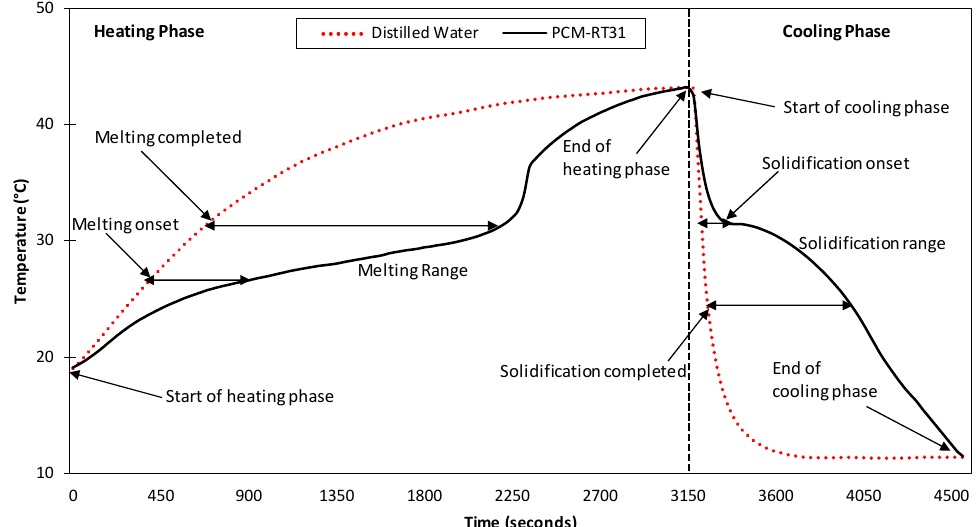
Figure 11. Temperature History Method (THM) curve for the PCM.